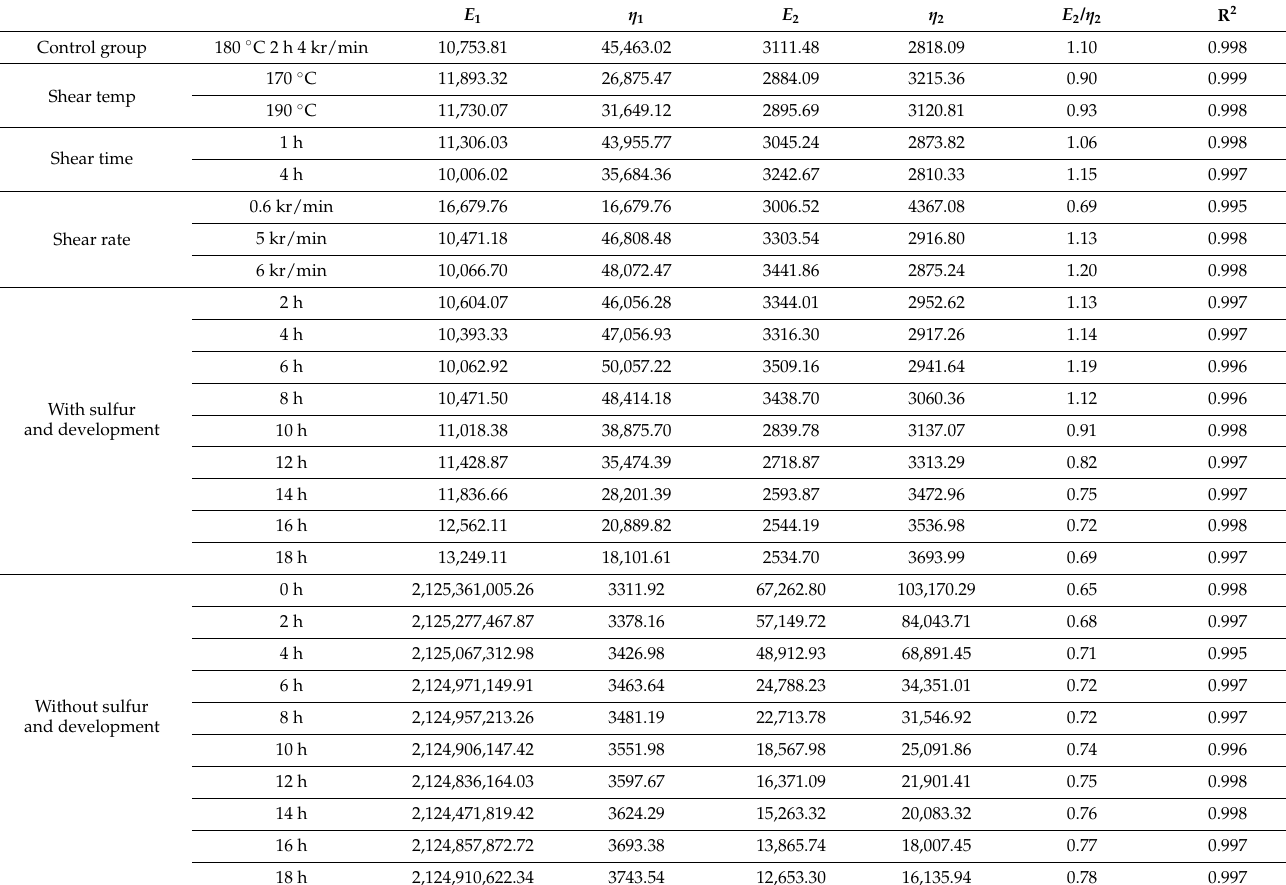
Table 4. Viscoelastic parameters of SBS-modified asphalt Burgers model under different preparation factors. E